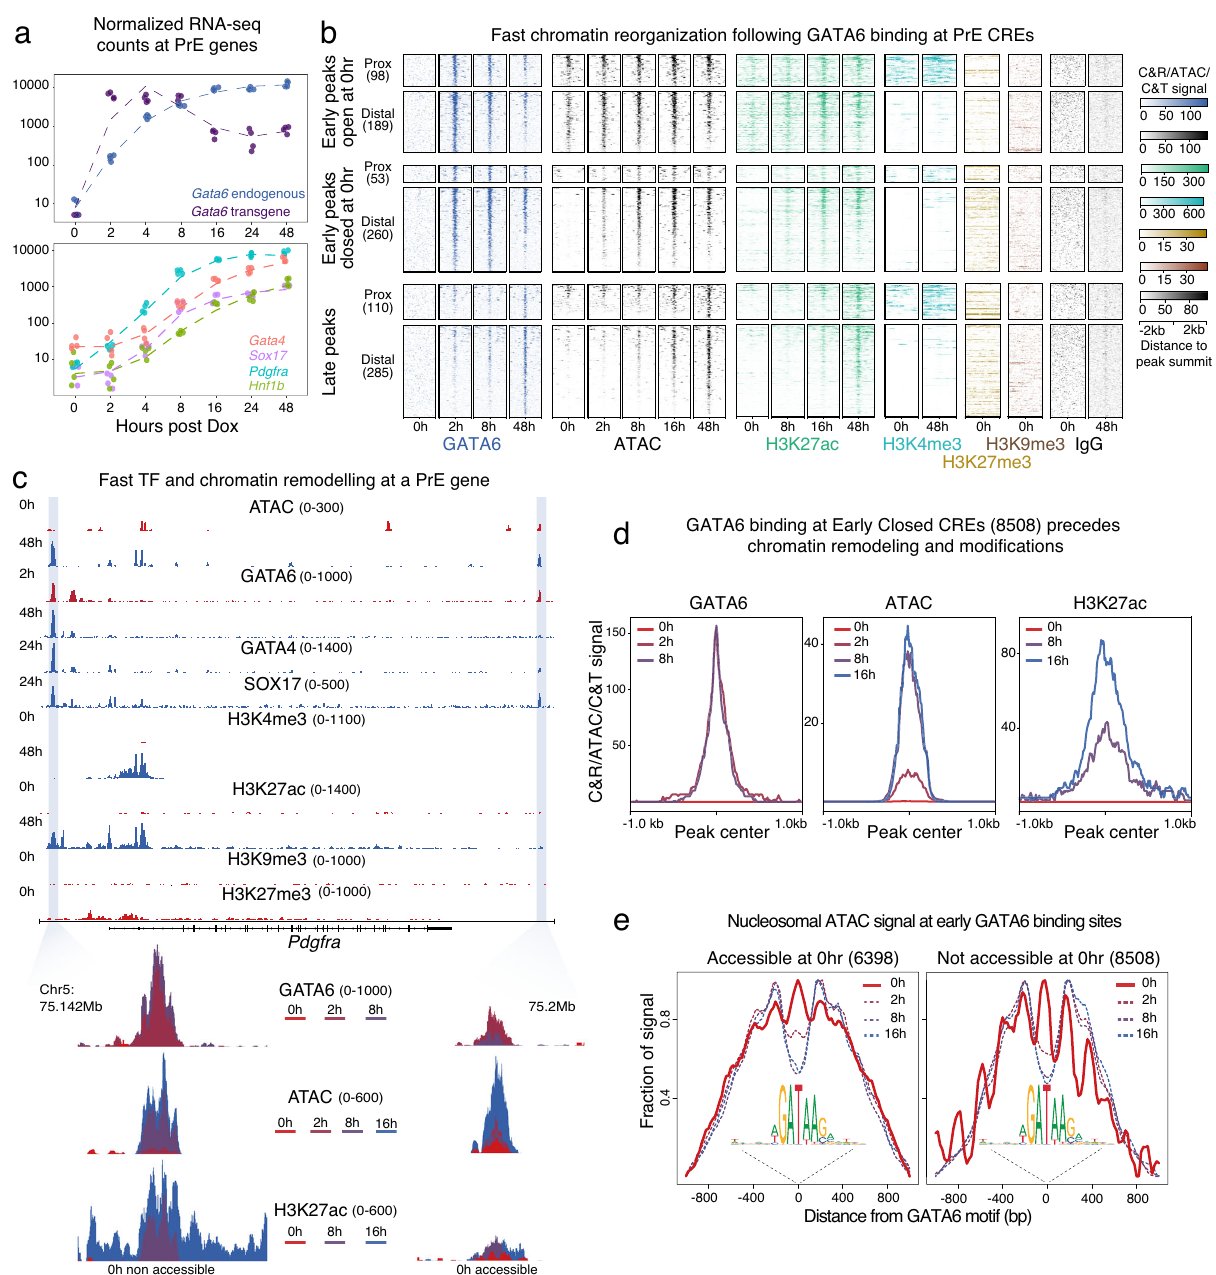
Fig. 2 GATA6 binding at PrE-speci fi c CREs precedes nucleosomal repositioning, changes in chromatin modi fi cations and transcriptional activation of the PrE transcriptional program. a Normalized RNA-seq counts show a gradual increase in endogenous Gata6 levels that followed Dox-induced expression of the Gata6 transgene (top panel). Transgene and endogenous transcripts accumulated at similar levels. Gradual gain in transcript levels of key PrE TFs that are downstream targets of GATA6 is shown in the bottom panel highlighting transcript accumulation within 4 h of GATA6 expression. b GATA6 peaks associated with PrE genes identi fi ed by CUT&RUN were classi fi ed as proximal (within 5 kb of TSSs) or distal CREs and as late peaks (bound by GATA6 only at 48 h) and early peaks (bound by GATA6 by 8 h). Based on ATAC-seq signal, early peaks were further categorized into Closed at 0 h or Open at 0 h. Heatmap compares differentiation-induced changes at the different peak categories in GATA6 binding, corresponding ATAC-seq signal, as well as histone marks associated with active (H3K27ac, H3K4me3) and repressive (H3K9me3, H3K27me3) chromatin. c Browser view of the Pdgfra locus. Highlighted regions depict changes in accessibility, binding by PrE TFs (GATA6, GATA4, SOX17), and changes in active and repressive histone marks. Two Pdgfra -putative CREs are shown, one accessible and one closed at 0 h. d Median pro fi le plots of normalized GATA6, ATAC, and H3K27ac signals at early GATA6 peaks closed at 0 h shows that GATA6 binding preceded increases in accessibility and H3K27ac. e Nucleosomal fraction of ATAC-seq signal as determined by ATACseqQC at the indicated timepoints over GATA6 motifs in two types of GATA6 early peaks: accessible before the onset of differentiation (left panel), and accessible only after GATA6 binding (right panel). In both peak types nucleosomal positioning over GATA6 motifs dropped quickly following GATA6 induction with stronger decrease at sites that were not accessible at 0 h. Source data are provided as a Source Data fi